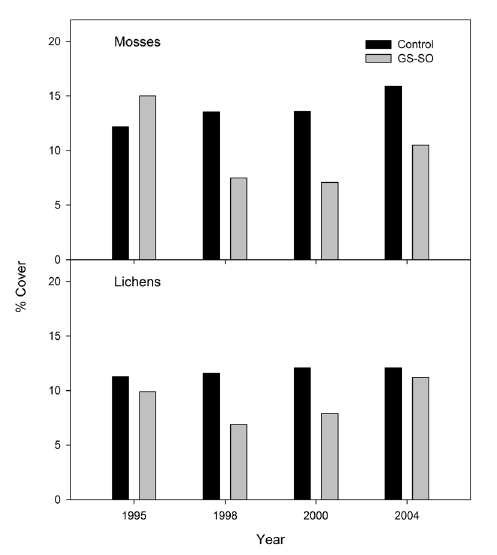
Figure 4. Percent cover of mosses (all moss species) and lichens (preferred forage species) in control versus irreg- ular group shelterwood (stem-only: GS-SO) harvesting plots under pre-harvest (1995) and post-harvest (1998, 2000, 2004) conditions on caribou winter range in west-central British Columbia. Adapted from Water- house et al.,